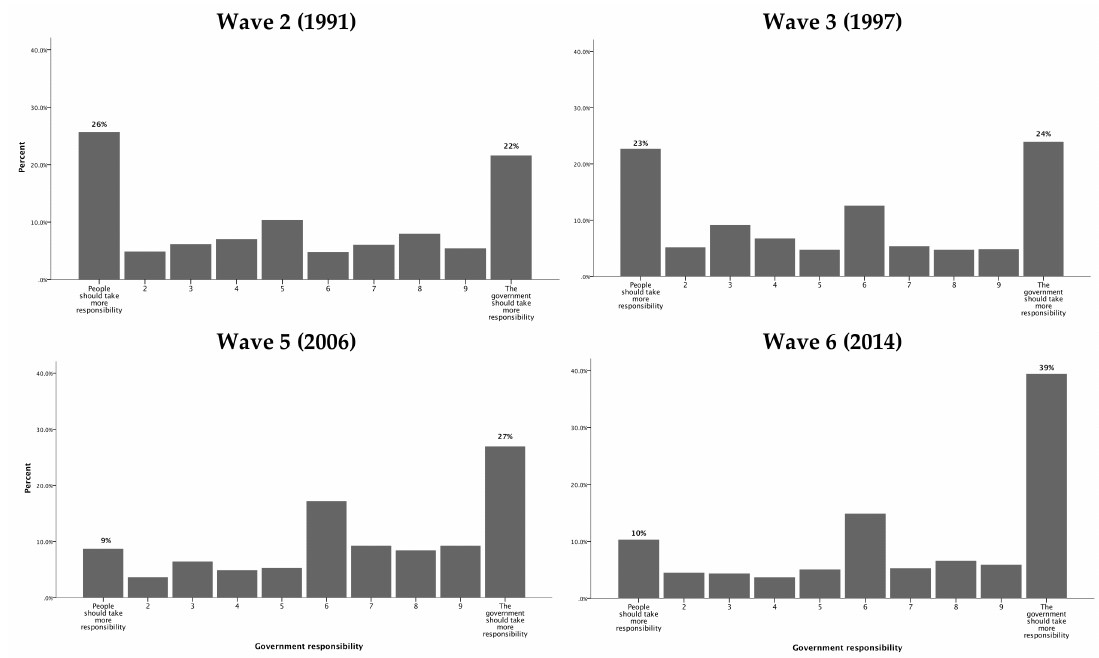
Chart 2. Distribution of GovResp in Brazil—4 waves (WVS). Source: World Values Survey 1981–2014 Longitudinal Aggregate v.20150418. World Values Survey Association (www.worldvaluessurvey.org). Aggregate